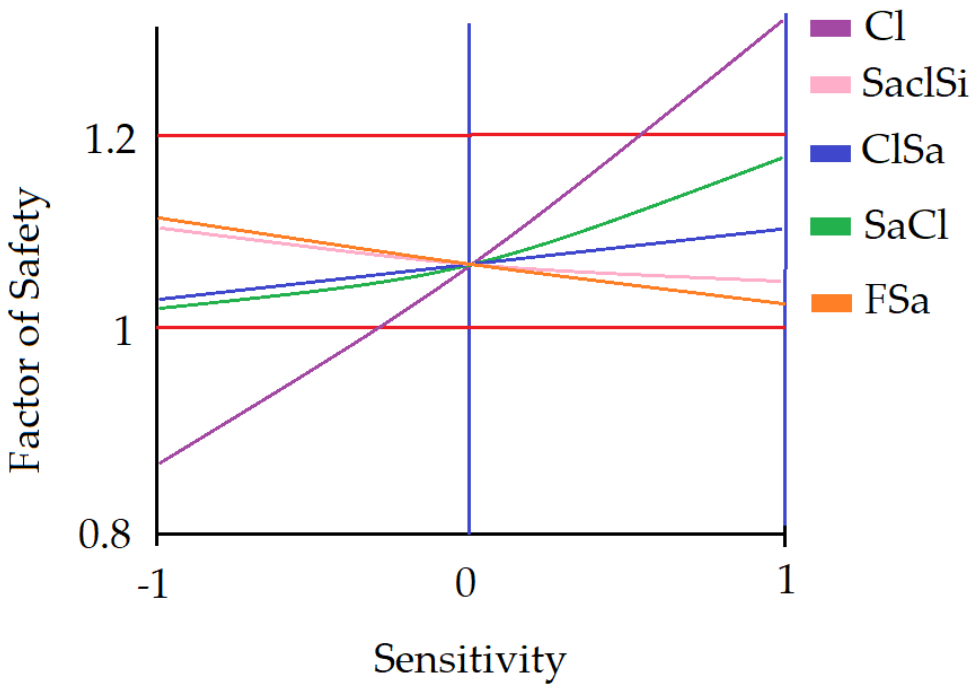
Figure 12. Sensitivity analysis for geotechnical parameters (Till (saclSi) (pink colour), Sandy Clay (saCl) (green colour), Clay (Cl) (purple colour), Clayey Sand (clSa) (blue colour), Fine Sand (FSa) (orange colour)) to identify the sensitivity of changes in parameters, the result of extreme weather conditions and the value of the safety factor. The red line indicate the value of Factor of Safety.